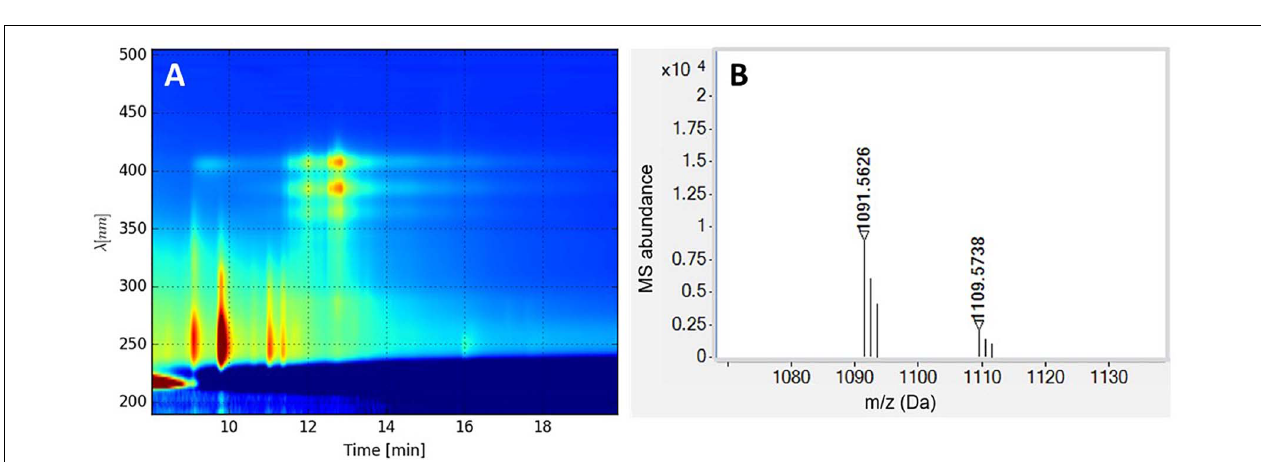
FIGURE 6 | Relative UV absorption chromatogram at 270 nm from the fractionation of DMSO extract of P08-E01 T (blue) overlayed with the growth inhibition results of Candida albicans CCUG 39333 (black), Enterococcus faecium CCUG 37832 (orange), and Kocuria rhizophila ATCC 9341 (green).